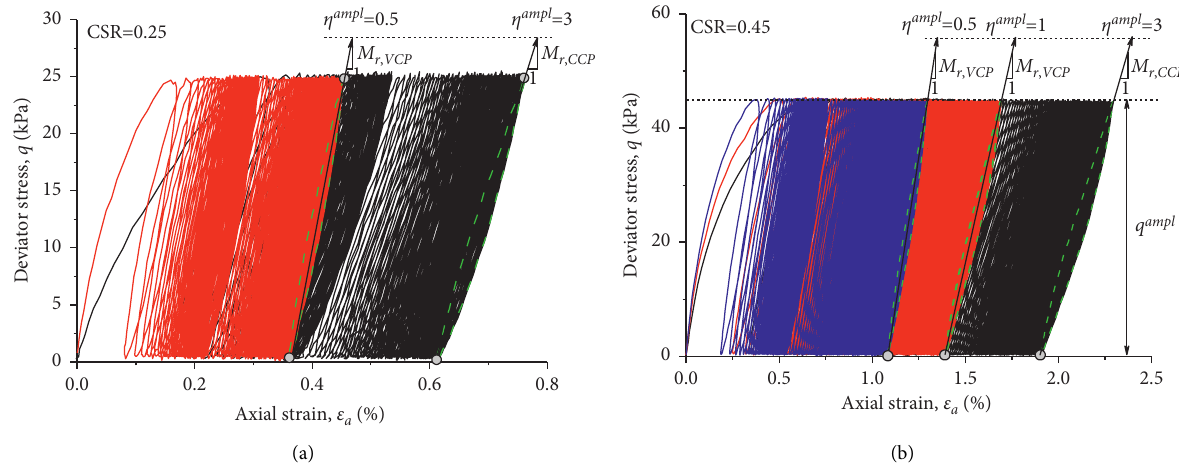
Figure 4: Comparison of typical axial cyclic stress-strain loops between CCP and VCP conditions: (a) CSR � 0.25; (b) CSR � 0.45.